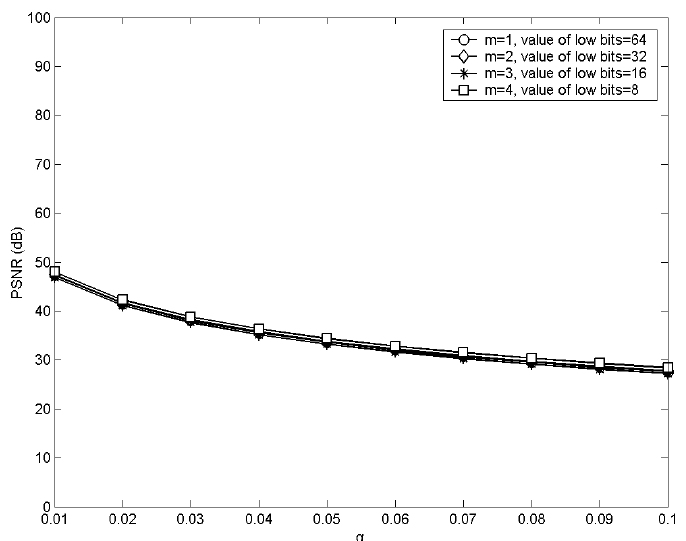
Figure 6. The qualities of the images embedded with hidden data with different values of α by using Lena as the host